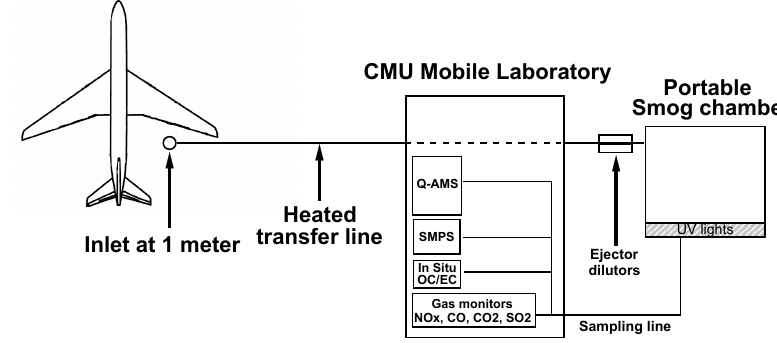
Fig. 1. Schematic diagram of experimental setup for the photo-oxidation experiments. Emissions were sampled from a KC-135 Stratotanker inboard engine through an inlet installed one-meter downstream of the engine exit plane. Emissions were transferred into a portable smog chamber and monitored throughout the experiment with instruments onboard the CMU Mobile Laboratory. The figure is not-to-scale; the smog chamber and mobile laboratory were located about 3-m from the tip of the